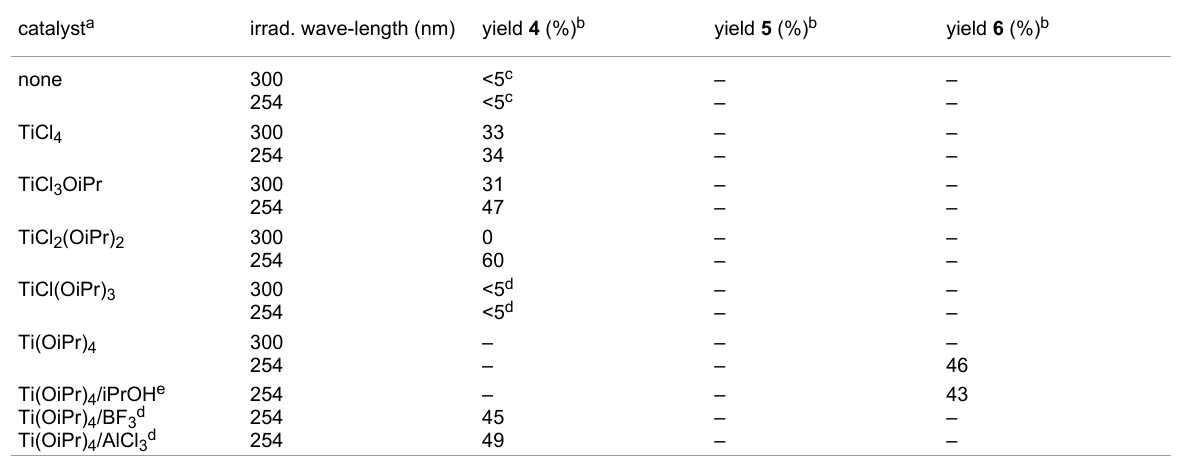
Table 1: Homogeneous sensitizer variation for the acetophenone model reaction. catalyst a